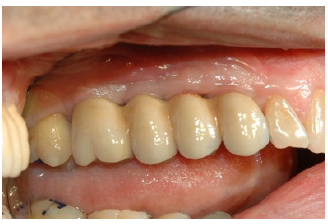
Figure 12. Cementing the superstructure.